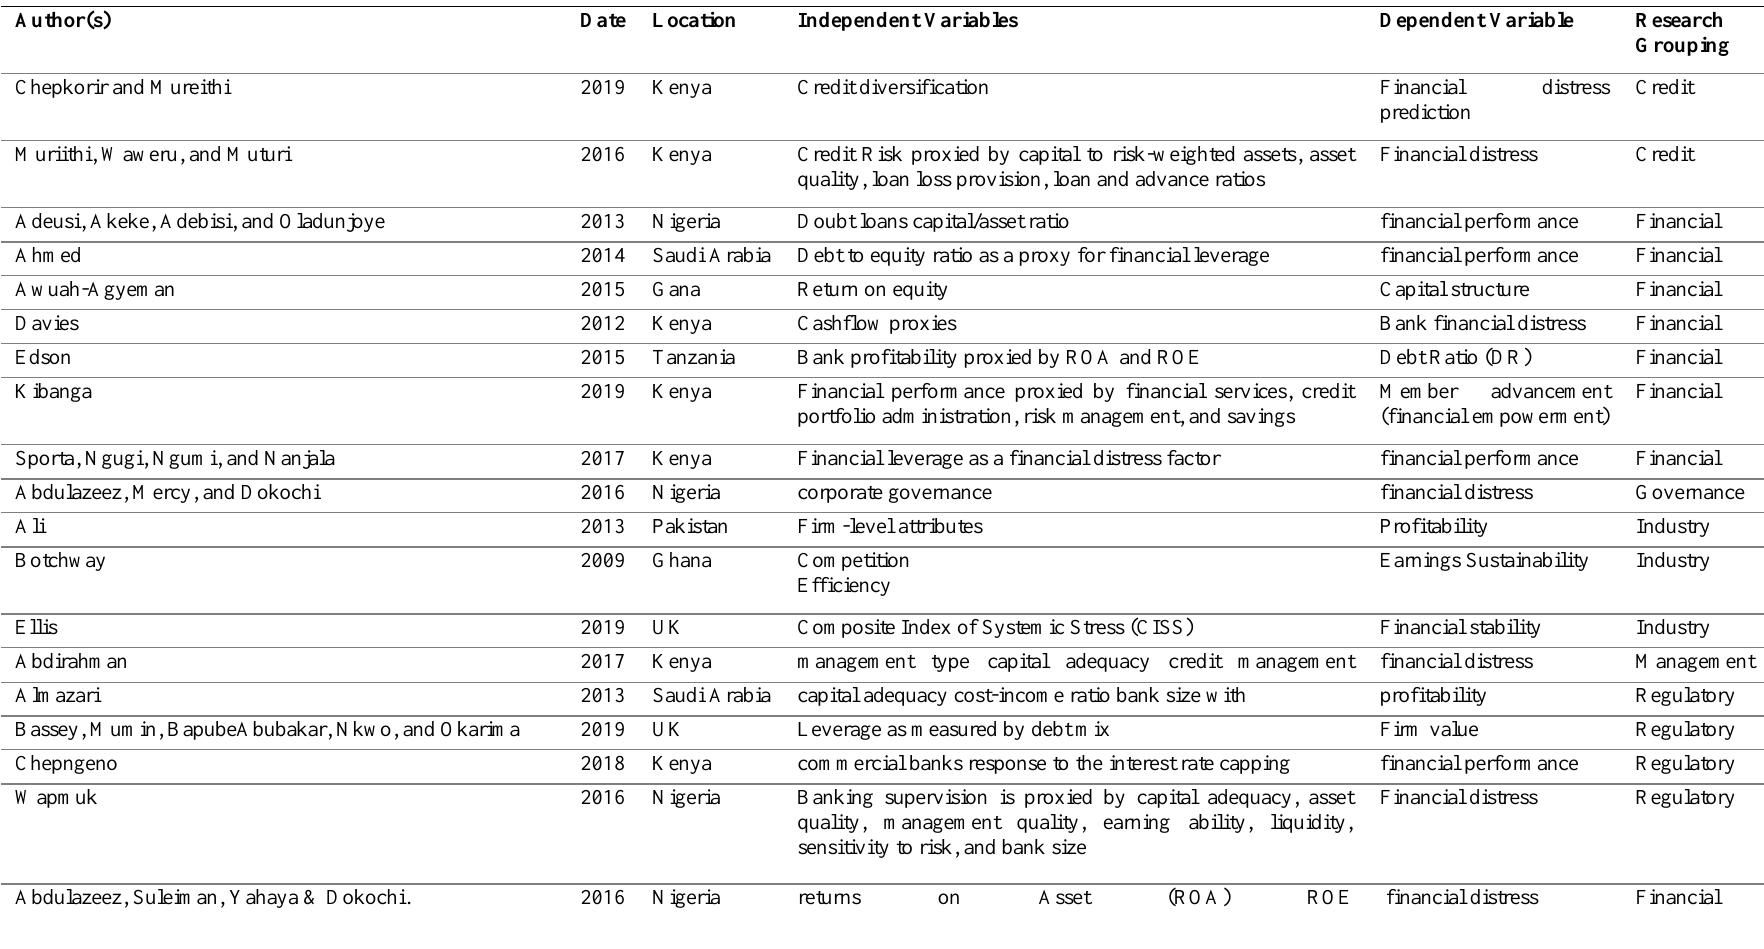
Table 1: Empirical Research